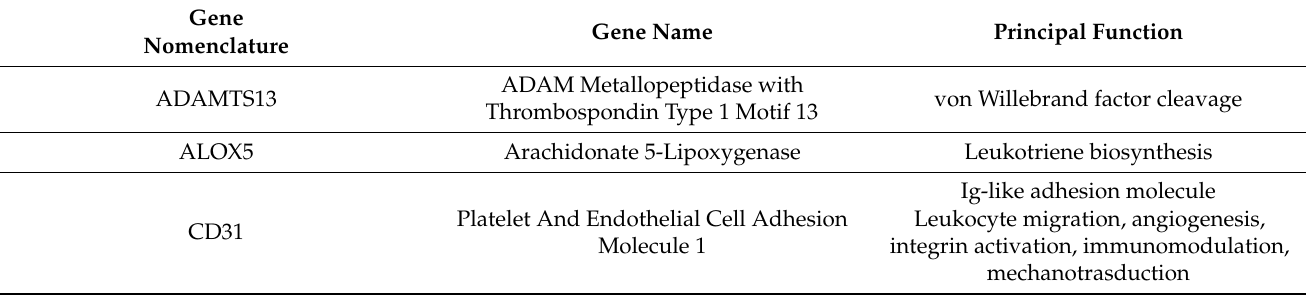
Table 1. Gene nomenclature and